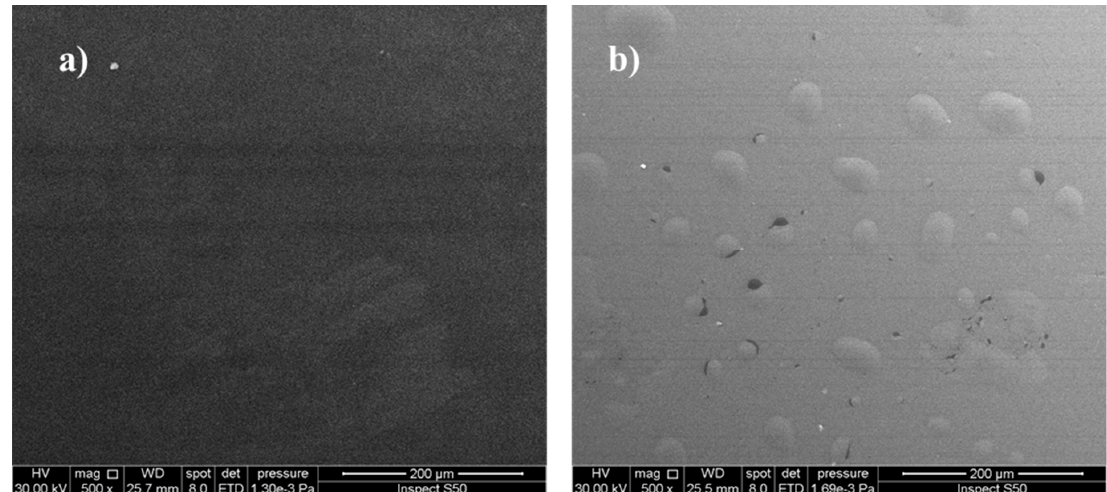
Figure 12. SEM images of ( a ) PVC film without irradiation, ( b ) PVC film after irradiation at 300 h.